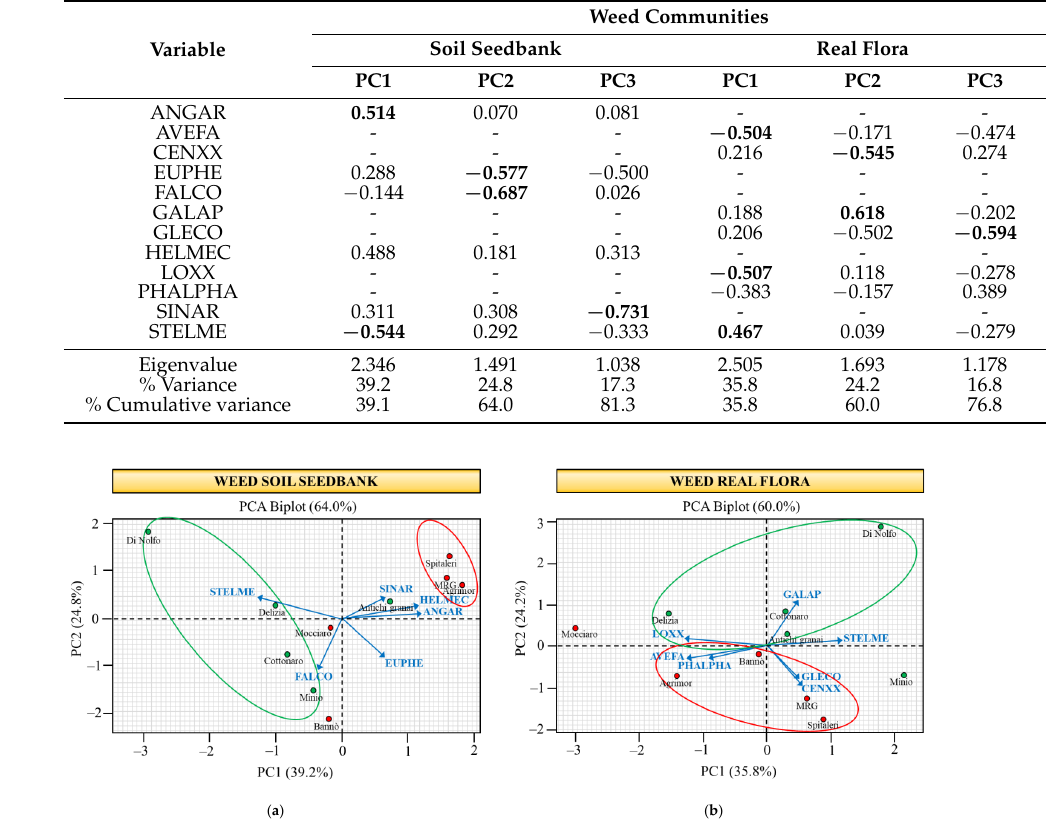
Table 5. Eigenvectors and eigen analysis of the first three PCs of 12 variables (6 and 7 major weeds for the soil seedbank and real flora, respectively) from PCA on the correlation matrix. Variables with the largest influence for each principal component are in bold.